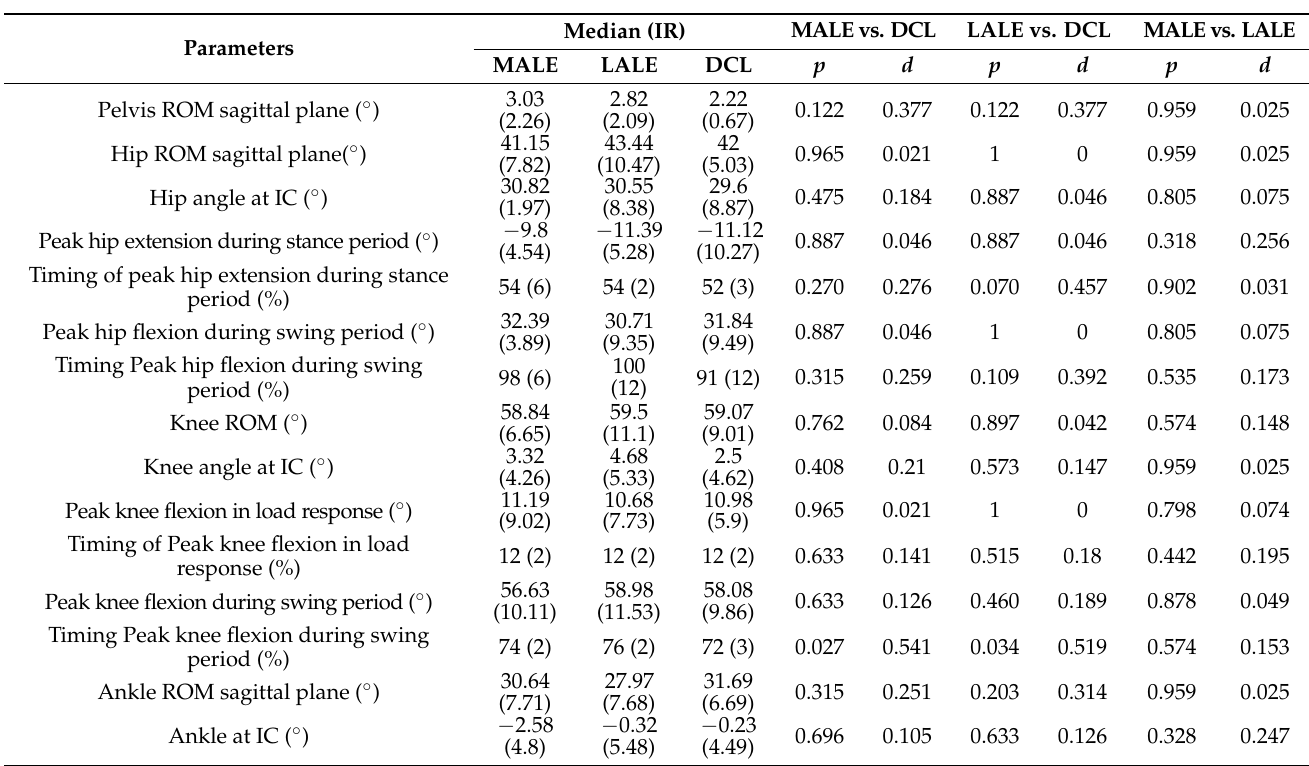
Table 3. Kinematic